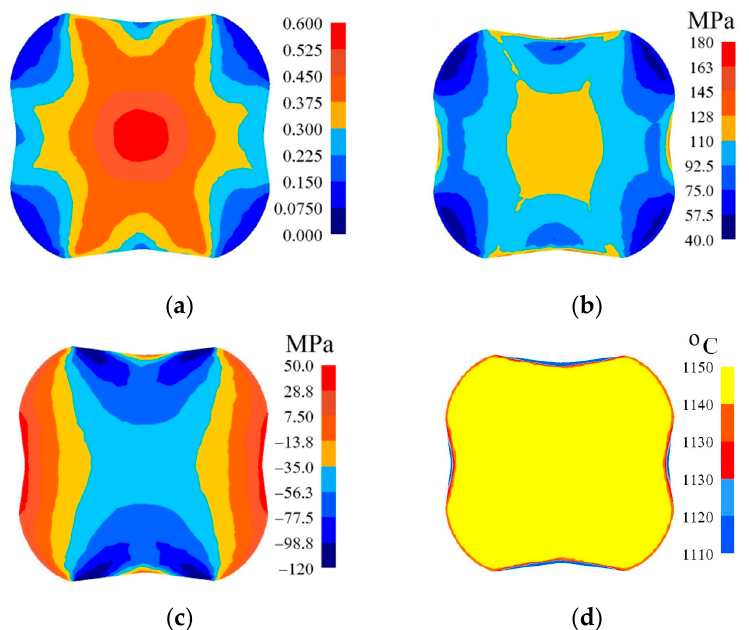
Figure 9. Distribution of the effective strain ( a ), effective stress ( b ), mean stresses ( c ), and temperature ( d ) on the cross-section of the workpiece in the course of forging in convex anvils after the second pass ( α c = 165°, ε c = 0.22).